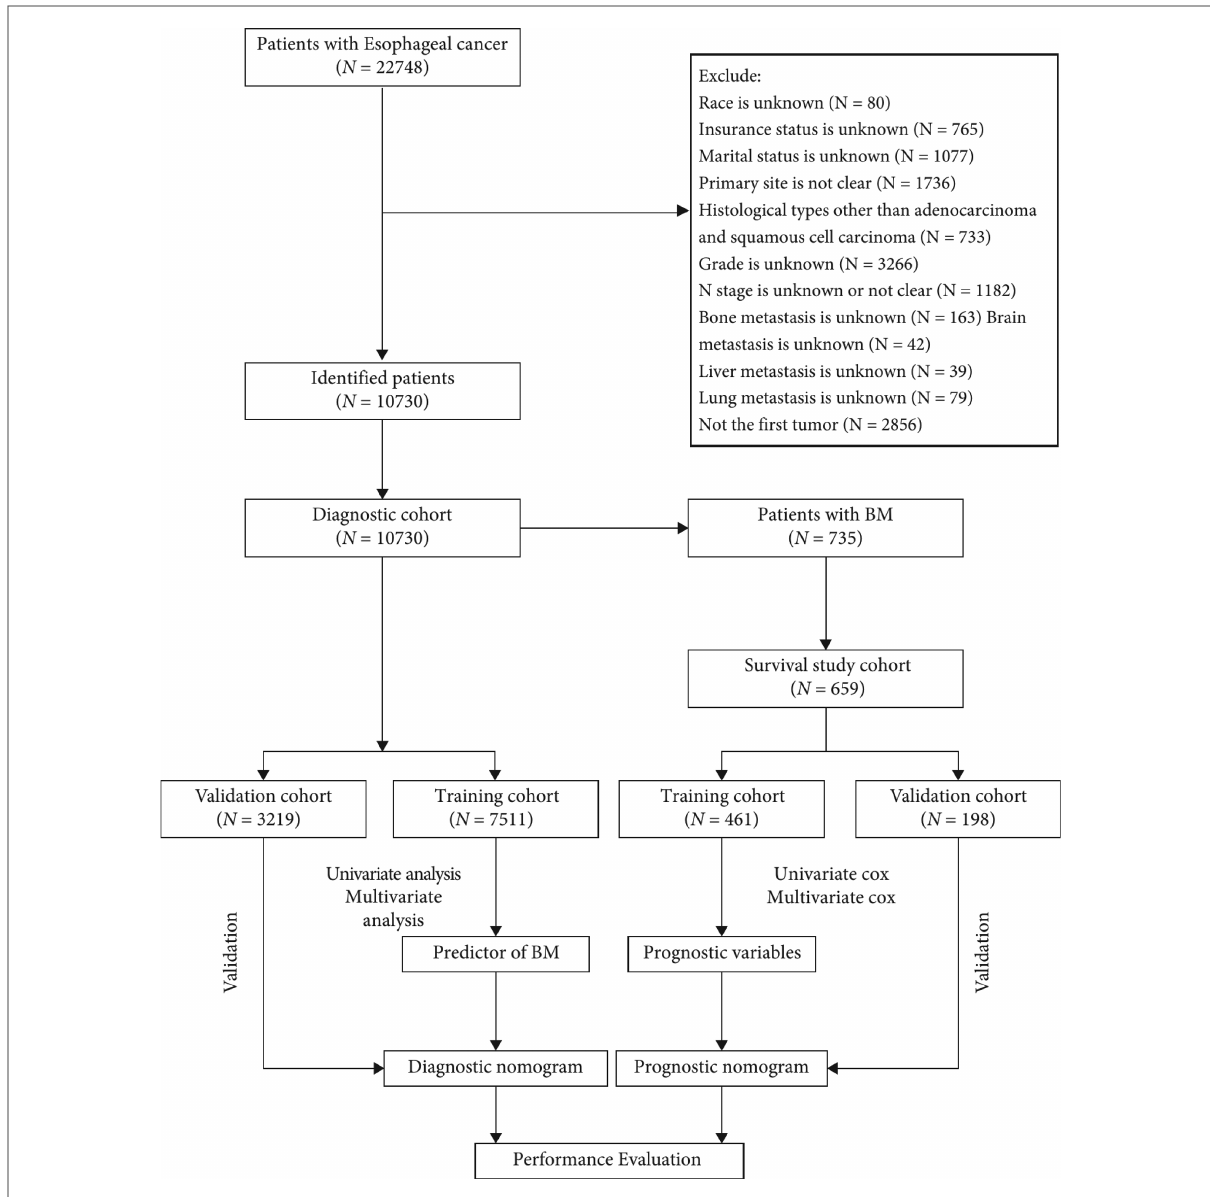
FIGURE 1 Flowchart of patient screening process and work fl ow of this